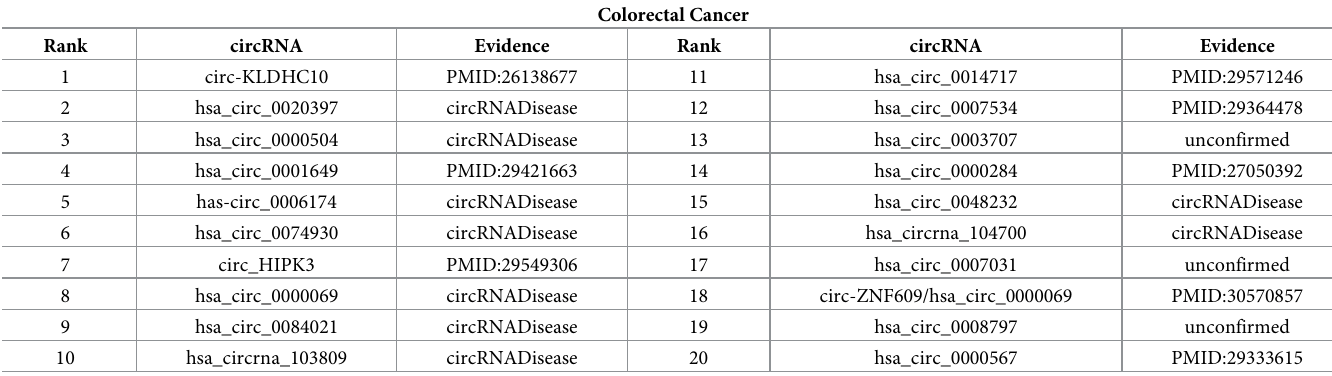
Table 7. The top 20 colorectal cancer related candidate